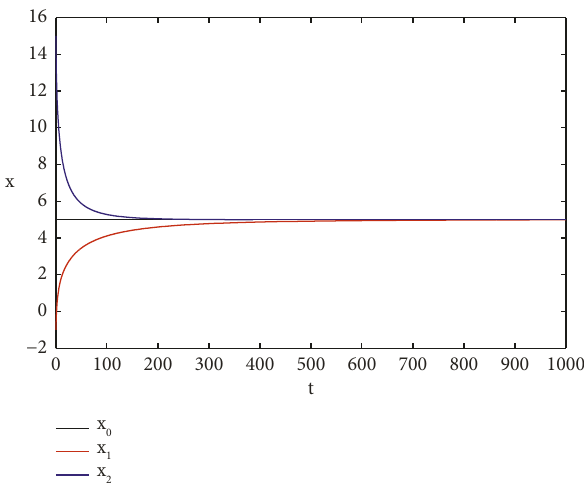
Figure 3: The states of the system of opinion formation model (5.3) with α � 0 .